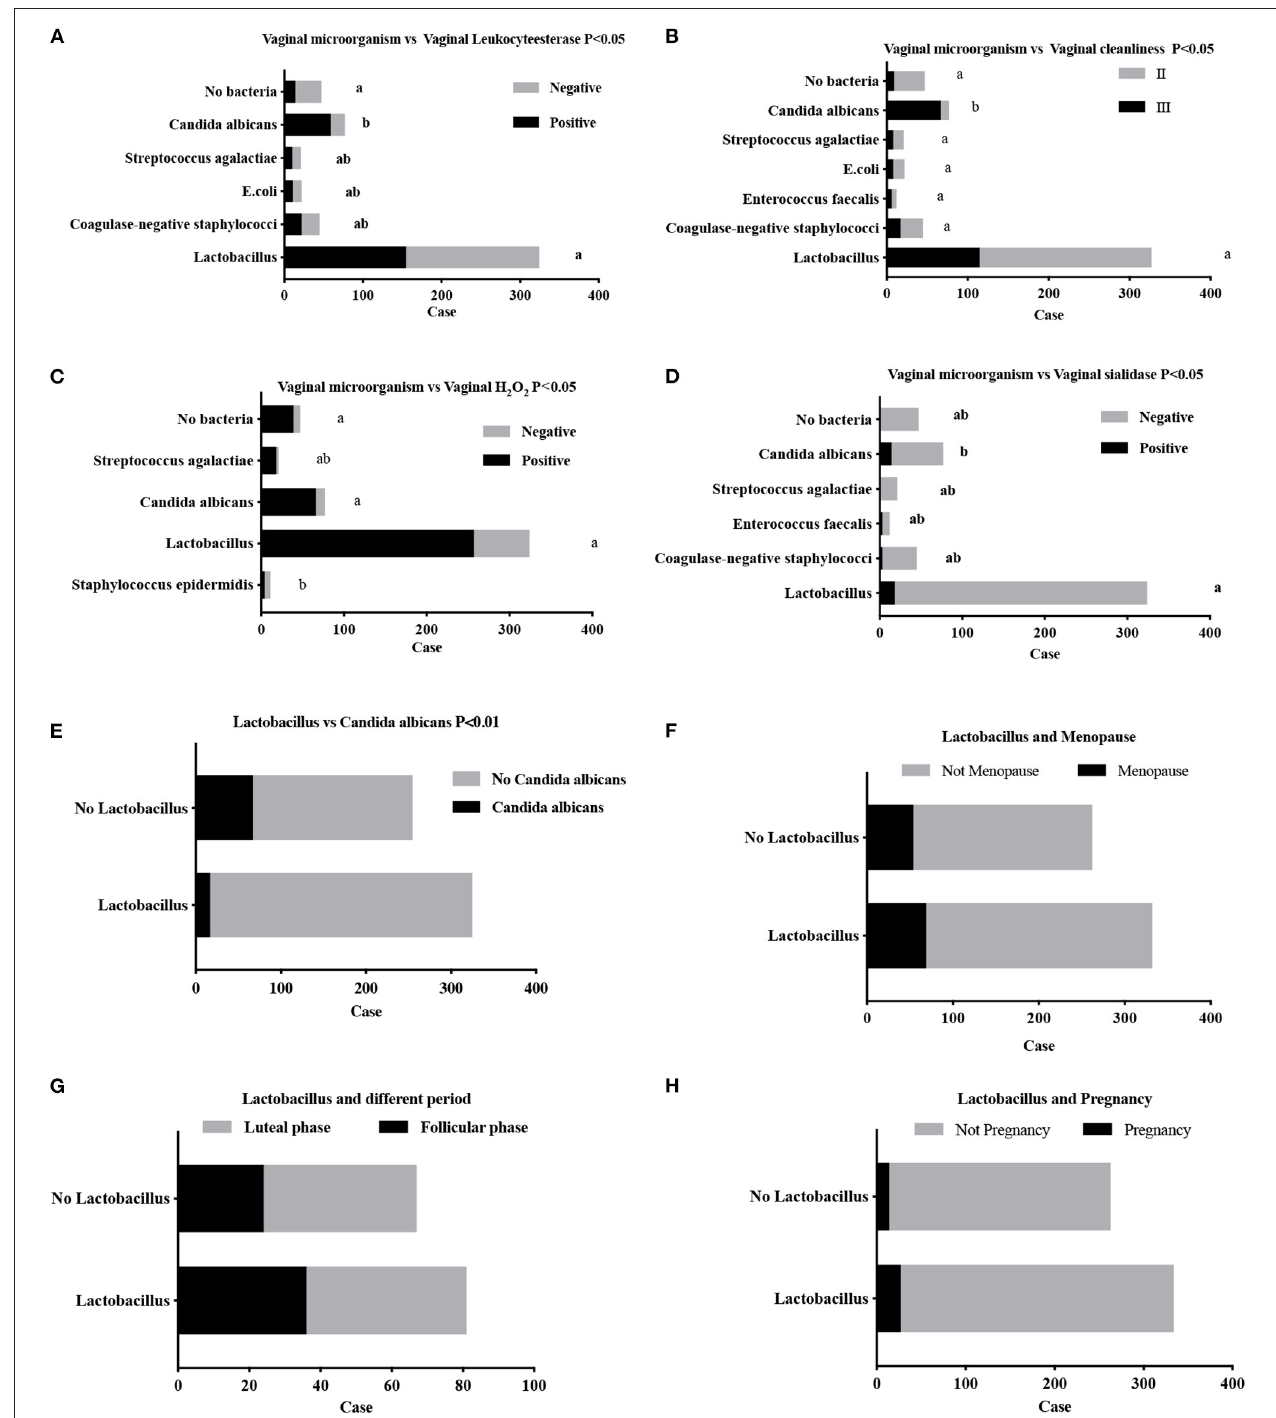
FIGURE 4 | Distribution of vaginal microorganisms in premenopausal and postmenopausal women using general bacterial culture techniques. (A,B) Vaginal secretion triple test: Candida albicans, the dominant bacterial population related to a higher positive rate of leukocyte esterase (A) and poorer cleanliness (B) . Staphylococcus epidermidis, the main bacterial population, was related to decreased hydrogen peroxide content (C) , a higher sialidase content existed in the Enterococcus faecalis population (D) . Women carrying Lactobacillus as the primary bacterial population were less susceptible to certain pathogens, such as Candida albicans (E) . There was no significant difference in lactobacillus as the dominant bacteria between the premenopausal and postmenopausal groups (F) . There was also no significant difference in Lactobacillus, as the dominant bacteria, distribution in different phases of the menstrual cycle (G) . Among them, Lactobacillus dominated 65.9% (27/41) in pregnant women and 55.22% (307/556) of non-pregnant women (H) .